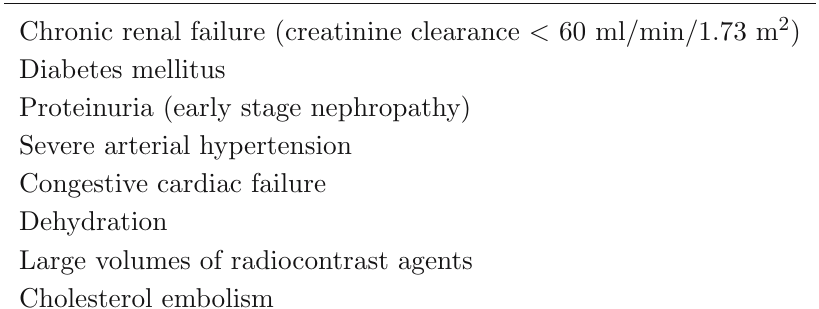
Table 2 Risk factors for radiocontrast-induced